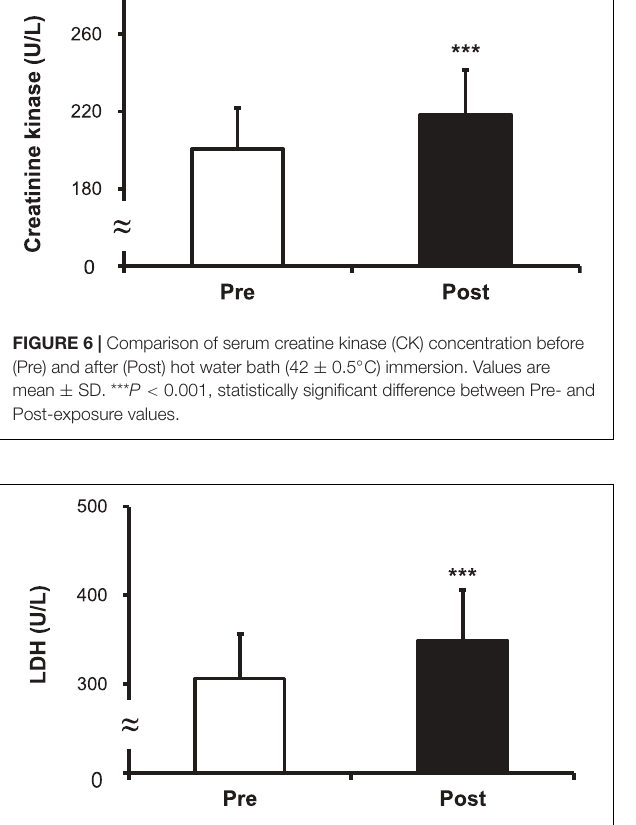
FIGURE 7 | Comparison of serum lactate dehydrogenase (LDH) concentration before (Pre) and after (Post) hot water bath (42 ± 0.5 ◦ C). Values are mean ± SD. *** P < 0.001, statistically significant difference between Pre- and Post-exposure